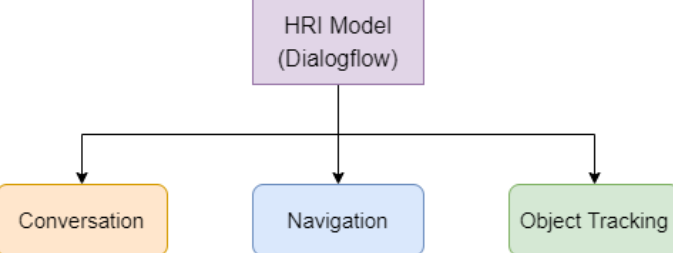
Figure 5. Score range of sentence sentiment.